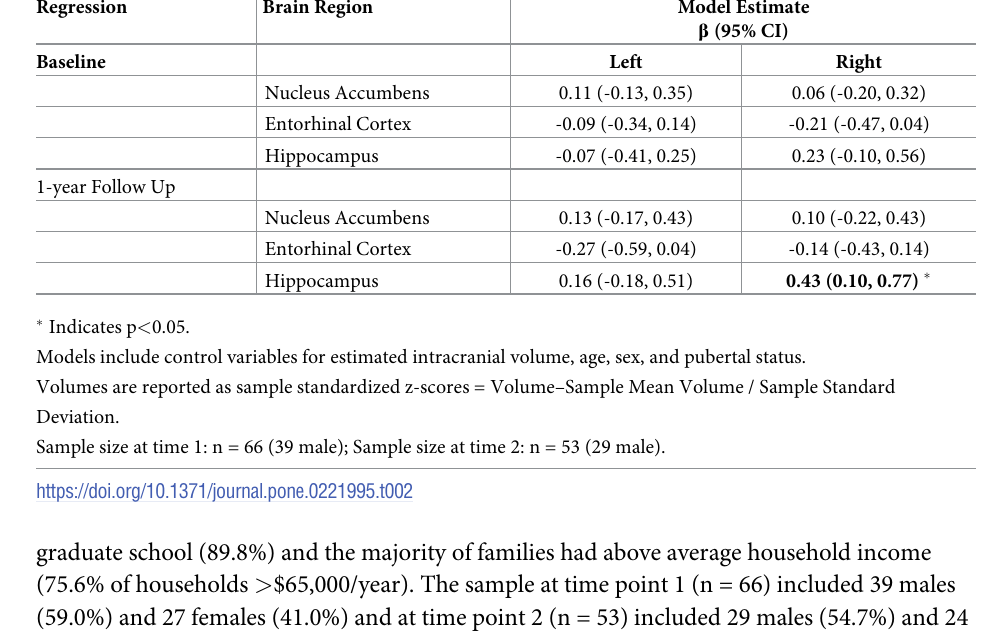
Table 2. Adjusted linear regressions of BMIz on concurrent regional brain volumes at times 1 and 2. Regression